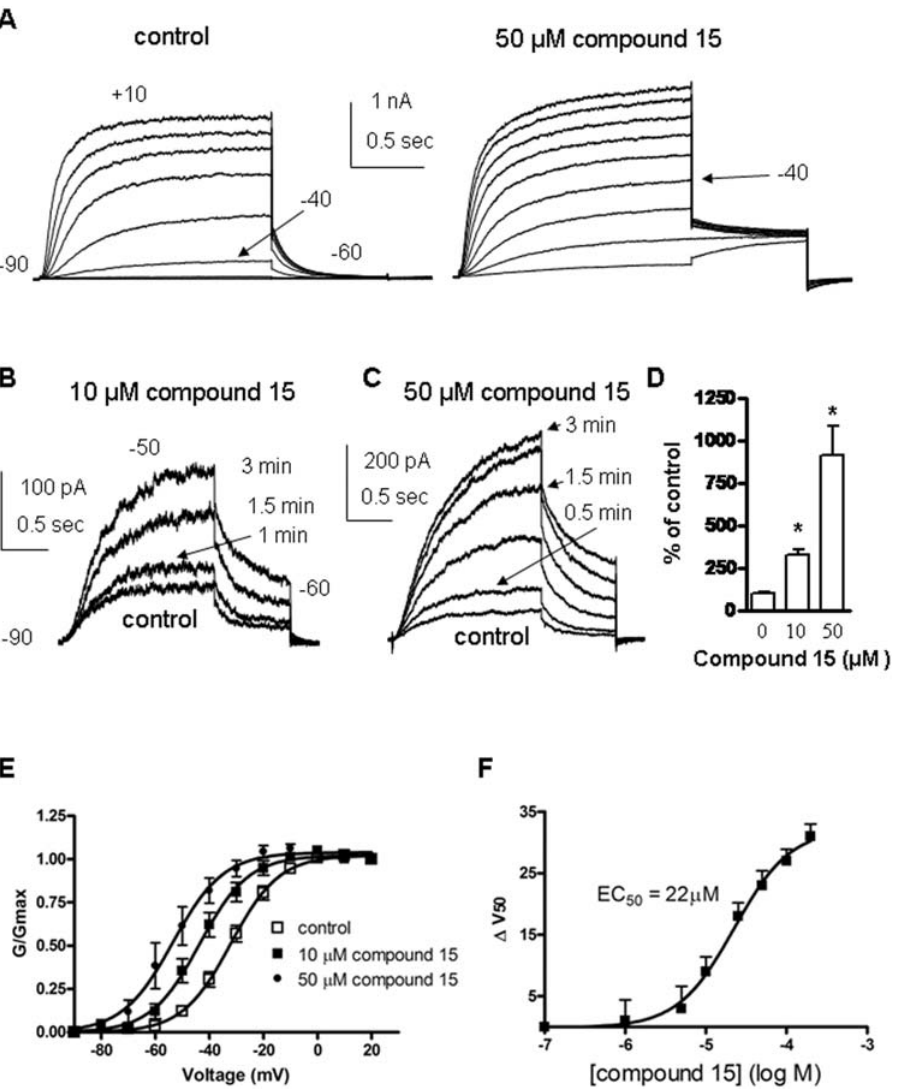
Figure 5. M-channel opener properties of compound 15 on Kv7.2/3 channels expressed in CHO cells. (A) Representative traces recorded from the same cell before (left panel) and after (right panel) external application 50 m M compound 15. The membrane potential was stepped from 2 90 mV (holding potential) to + 10 mV for 1.5 s pulse duration in 10 mV increments, followed by a repolarizing step to 2 60 mV. (B) and (C) Cells were stepped from 2 90 mV to 2 50 mV every 30 sec for 1.5 sec pulse duration. Current traces were recorded from the same cell in the absence (control) and presence of 10 m M (B) and 50 m M ( c ) compound 15. (D) The percentage of the current recorded at 2 50 mV is shown in the presence of 10 m M and 50 m M compound 15 or in its absence, the latter being the control of 100% (n=10; * p , 0.01). (E) The normalized conductance (G/Gmax) was plotted as a function of the test voltages, for control (open squares), 10 m M (solid squares) and 50 m M (diamonds) compound 15-treated cells. The activation curves were fitted using one Boltzmann function (n=5). (F ) The potency of compound 15 was determined by the extent of left-shift ( D V 50 ), plotted as a function of compound 15 concentration and fitted by a sigmoidal function yielding an EC 50 value of 22 6 1 m M (n=5).